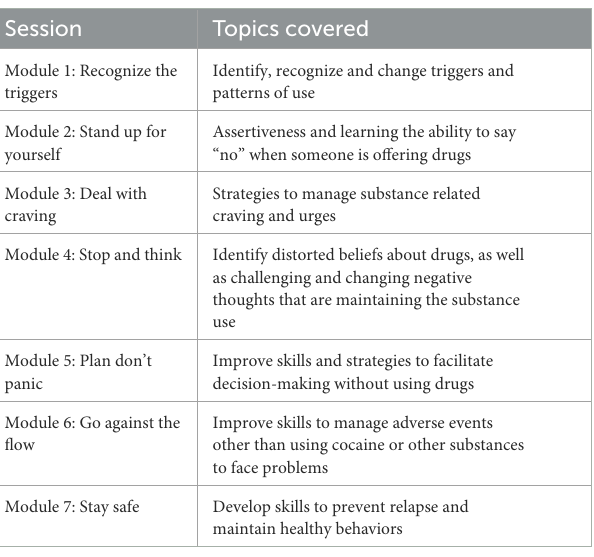
TABLE 1 Content of the 8-week CBT4CBT